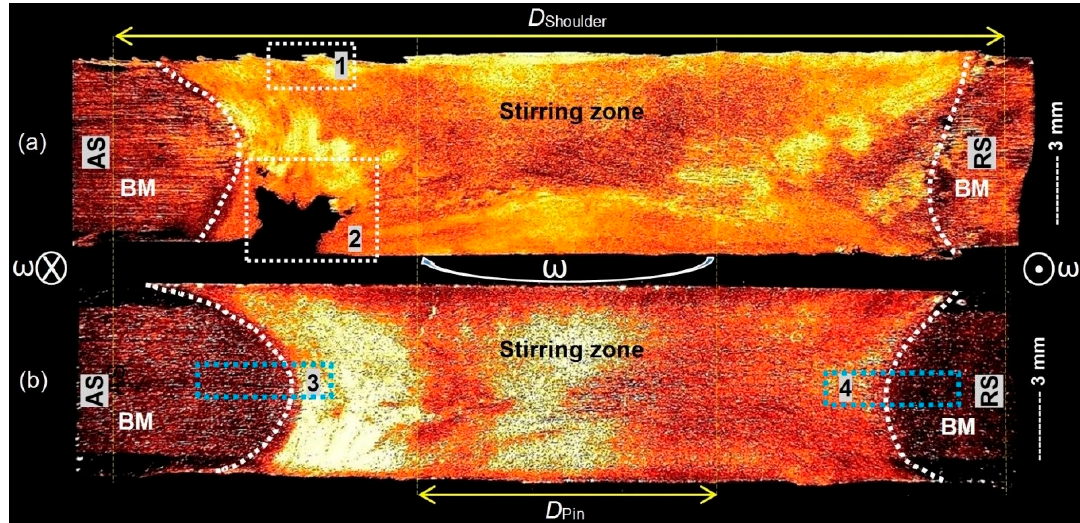
Figure 2. Macrostructure of the cross-section of the BFSW joint for two different welding speeds (etched by reagent A), ( a ) (w = 400 rpm, 350 mm/min), and ( b ) (w = 650 rpm, 400 mm/min). Arrows show proposed internal flows. Dashed white lines show the SZ borders. (1) weld crown, (2) tunnel void, (3) AS border, and (3) RS border.